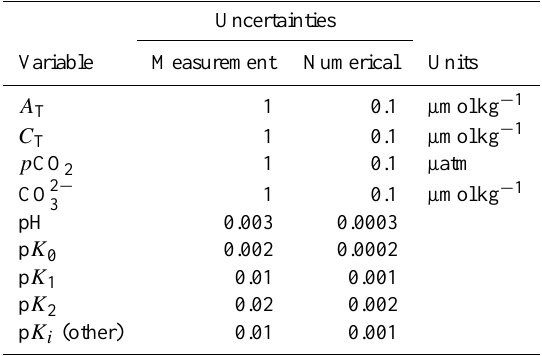
Table 8. Desired measurement and numerical